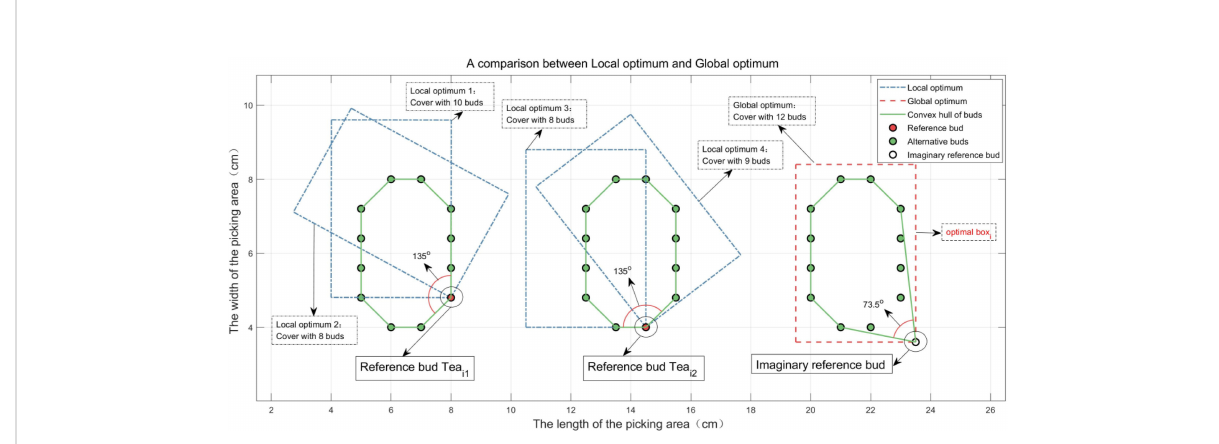
FIGURE 8 Comparison of local optimum and global optimum.